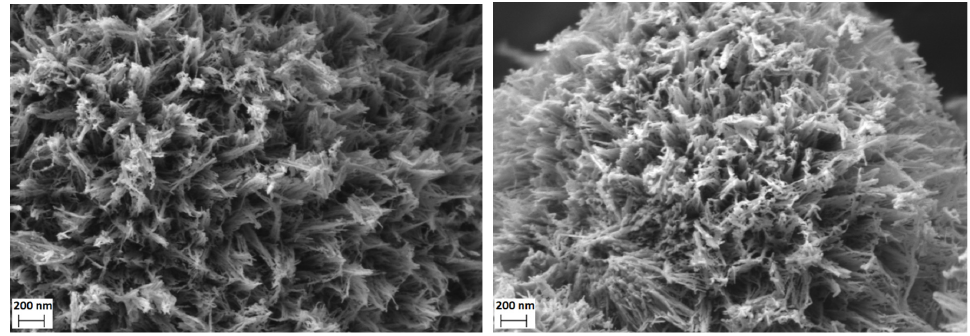
Figure 5. SEM images of samples (synthesis A) treated at 650 °C ( left ) and 700 °C ( right ). Table 3. Specific surface areas and size of anatase crystallites of sample A, calcinated at different temperatures.